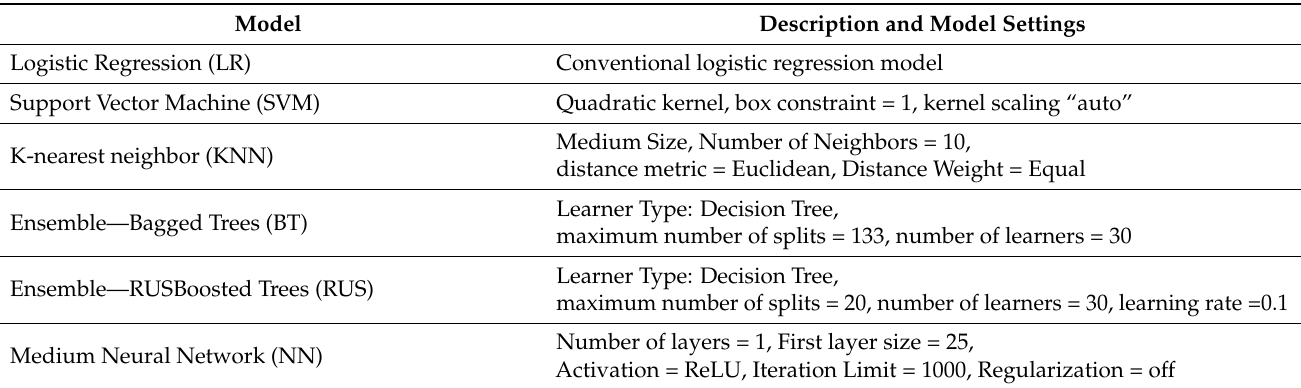
Table 2. Machine Learning models investigated and their associated descriptions and settings. Model Description and Model